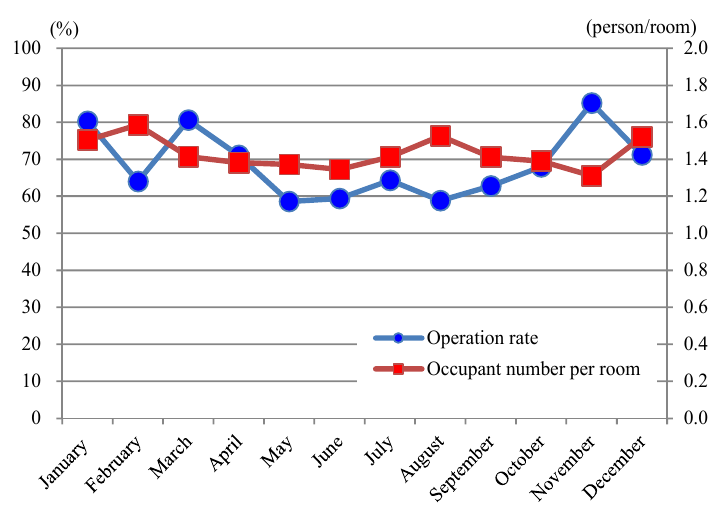
Figure 4. The operation rate and the transition of occupant number per room.